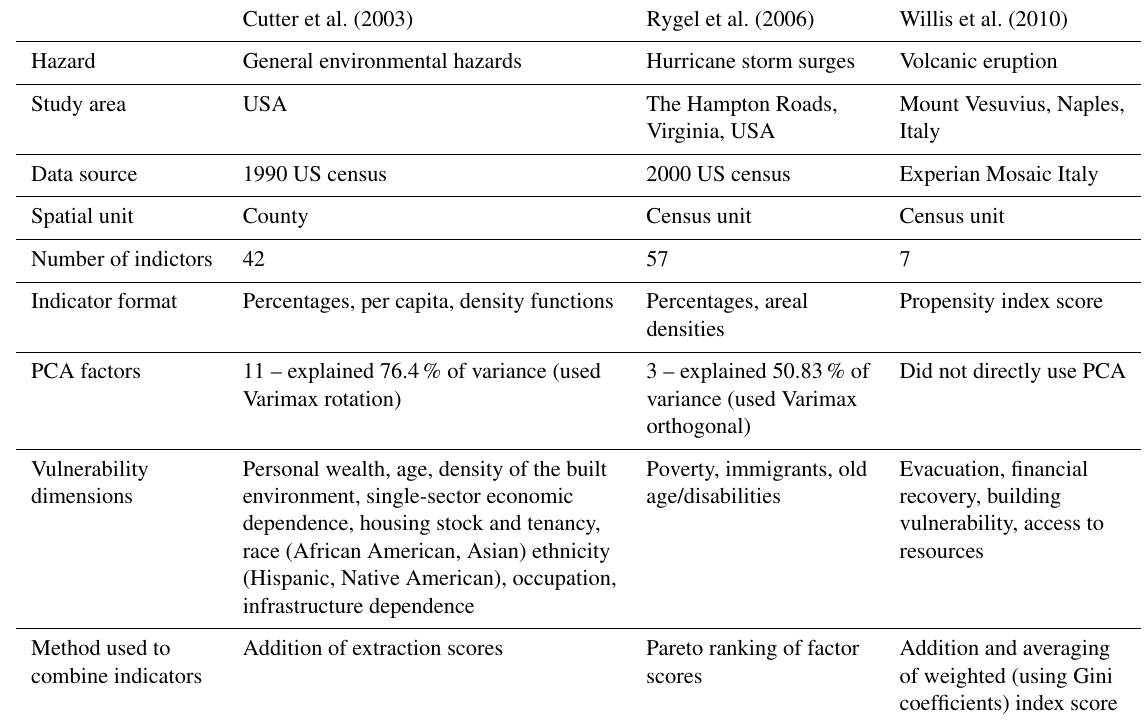
Table 1. Summary of the three social vulnerability methods applied within this